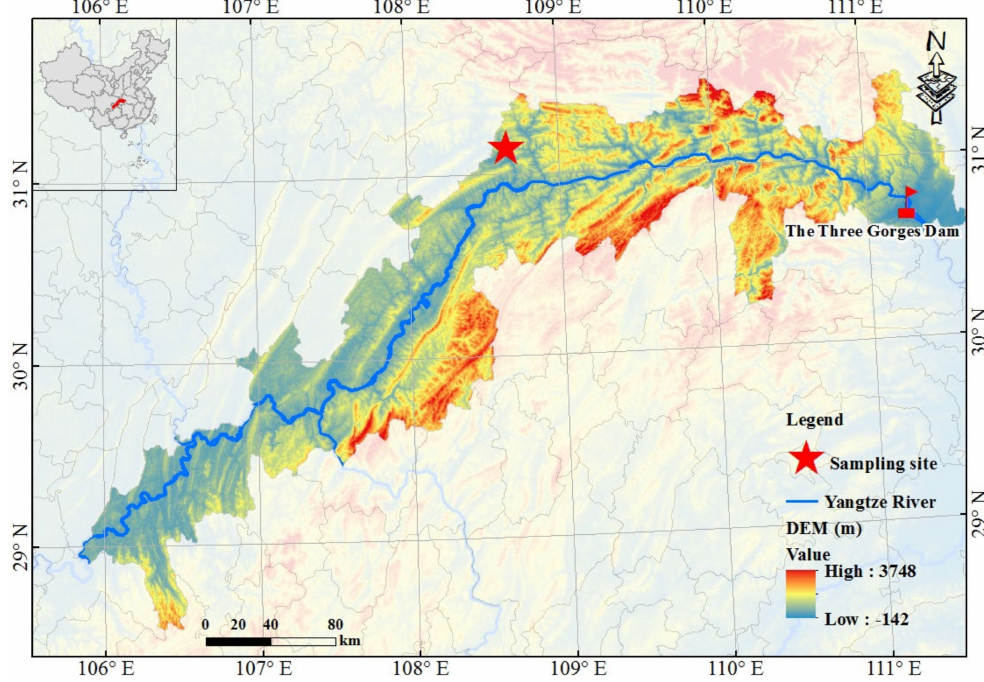
Figure 1. The location of sampling sites and DEM in the WFLZ of the